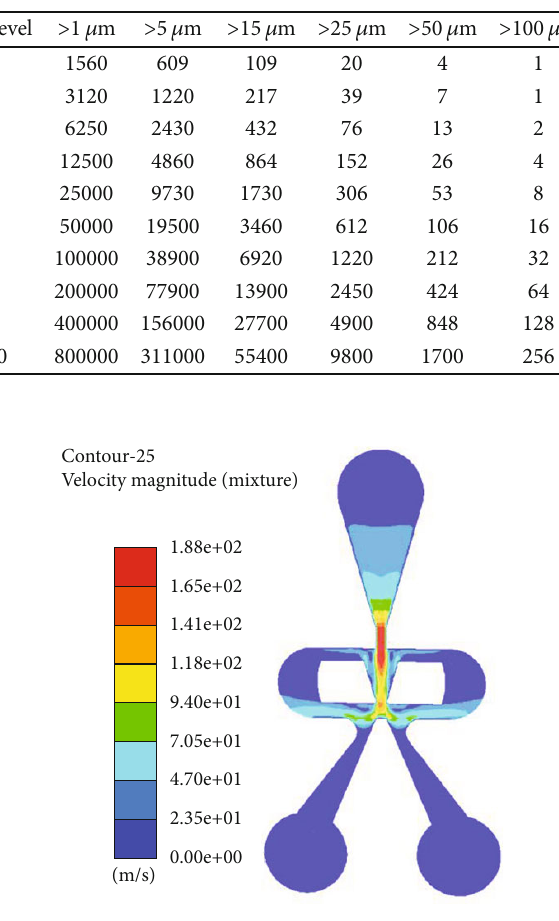
Figure 11: The fl ow velocity distribution of pilot stage.